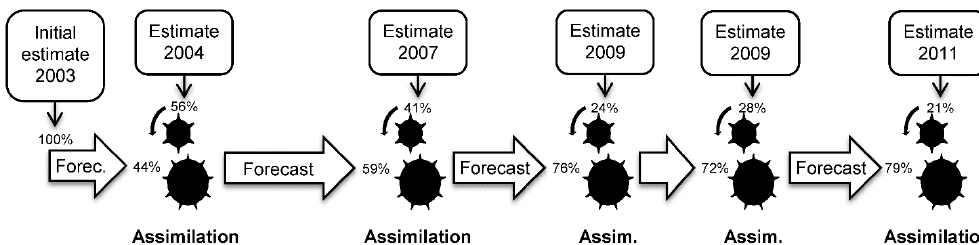
Figure 3. Illustration of the data assimilation procedure used in this study. The years state the growth season for each remote sensing data acquisition. The percentage is an example of the Kalman Gain, i.e. , the amount of information that is included from each source when assimilating. The Kalman Gain value is different for each 18 m × 18 m pixel within the validation plot. There were two acquisitions with growth season 2009 and, therefore, no forecast of the growth was needed between these two.